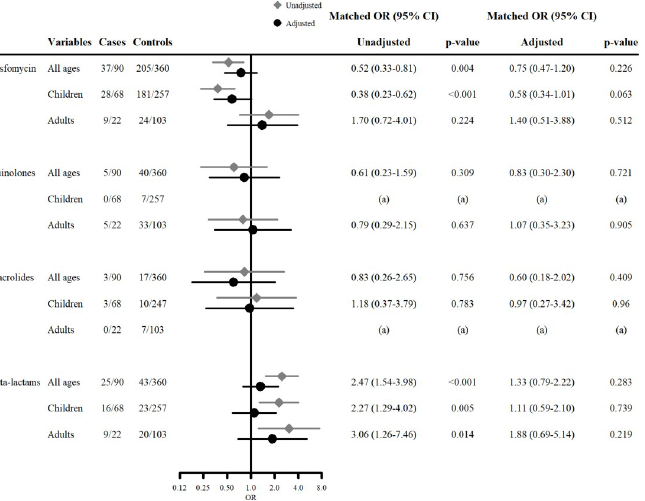
Fig 3. The association between different type of antibiotics and development of HUS. Unadjusted matched odds ratios were calculated by univariable conditional logistic regression analysis. Adjusted matched odds ratios were calculated by multivariable conditional logistic regression analysis. The following covariates were used for the analyses: age, sex, area, presence of bloody stool, initial white blood cell (WBC) count, initial CRP level, antidiarrheal agent use, and serotype O157. (a) In analyses for the association between quinolones and HUS in children and between macrolides and HUS in adults, the frequency of cases was zero and the odds ratio could not be properly estimated.